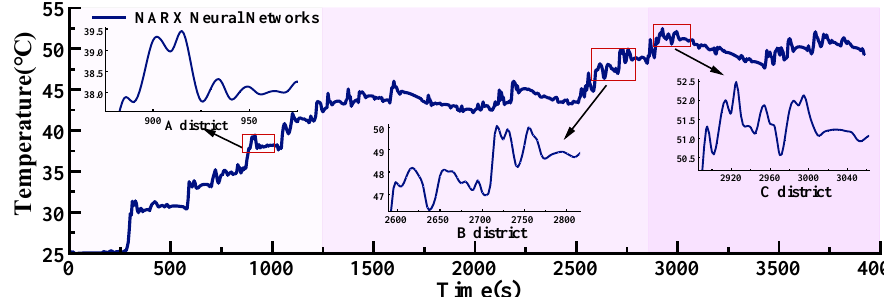
Figure 16. Battery temperature predicted by NARX neural network.